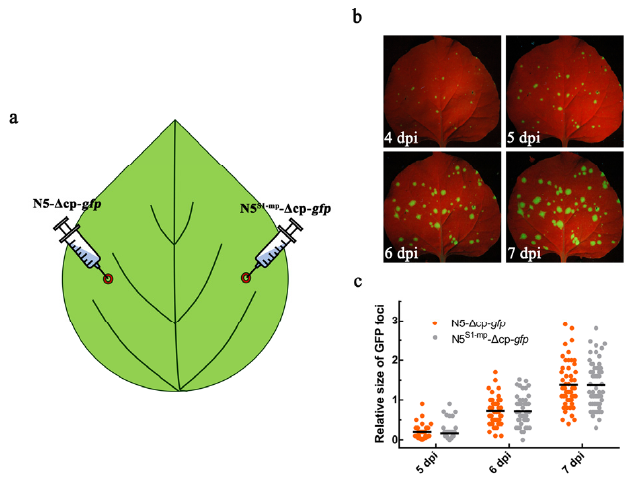
Figure 4. Comparison of both MPs in facilitating viral cell-to-cell movement. ( a ) Schematic diagram of agroinfiltration to inoculate N5- Δ cp- gfp (left half) and N5 S1-MP - Δ cp- gfp (right half) on the same leaf of N. benthamaina plants. As shown in Figure 4a, N5- Δ cp- gfp was constructed by deleting the CP gene in N5- gfp , and N5 S1-MP - Δ cp- gfp was constructed by replacing MP in N5- Δ cp- gfp with S1-MP. ( b ) Distribution patterns of GFP fluorescence foci produced from N5- Δ cp- gfp and N5 S1-MP - Δ cp- gfp at 5, 6, and 7 dpi . The concentration of Agrobacterium cells harboring N5- Δ cp- gfp or N5 S1-MP - Δ cp- gfp was 0.0001 at OD 595 . ( c ) Statistic results of GFP foci measured from N5- Δ cp - gfp and N5 S1-MP - Δ cp- gfp at 5, 6, and 7 dpi. All GFP foci visualized at 5 dpi were measured again by Image J at 6 and 7 dpi. The collected data were analyzed with GraphPad Prism. The dark lines indicate the mean values of GFP foci size at a certain time point.